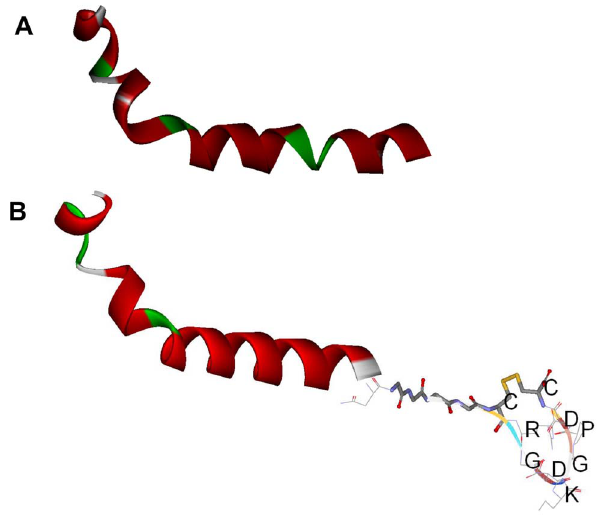
Figure 6. Modeling of the structures of the composed peptides by DS|Built homology model. A. T a 1 B. T a